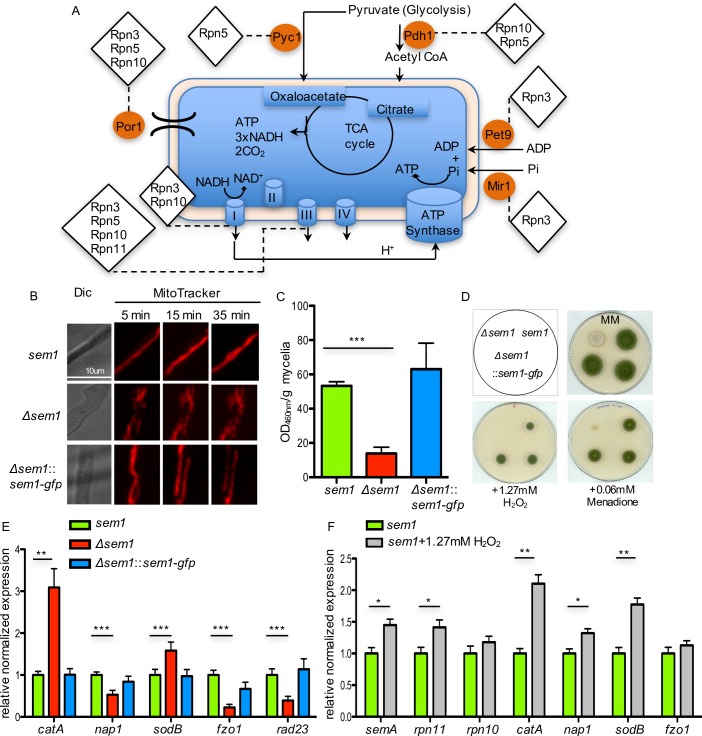
Sem1 is required for an appropriate oxidative stress response in A. nidulans.(A) 19S RP without Sem1 associates with TCA cycle and respiratory chain related proteins. Interacting enzymes are marked with orange circles and the respective 19S regulatory particle subunits associated with them are indicated with diamonds. (B) Mitochondria morphology is compromised in Δsem1 mutant strain as observed by time-lapse microscopy with the fluorescence marker MitoTracker. Hypha from wildtype, complementation and deletion strain were observed 5 min, 15 min and 35 min after the addition of the MitoTracker. Scale bar: 10 μm. (C) The total cellular NADH production is reduced in the Δsem1 mutant strain. n = 5, ***p<0.001. (D) Oxidative stress inducing compounds inhibit Δsem1 colony growth. Respective strains were spotted on minimal medium plates (MM, control) and MM plates supplemented as indicated, n = 4. Two complementation strains served as internal biological replications. (E)
Δsem1 mutant strain induced the transcription of the antioxidants encoding genes catA and sodB. Results are shown as relative expression compared to sem1, n = 3, ***p<0.001. (F)
sem1 and rpn11 are induced as response to oxidative stress in sem1+1.27mM H2O2. Bars represent mean values of four independent experiments, ***p<0.001 (see also S6 Fig).